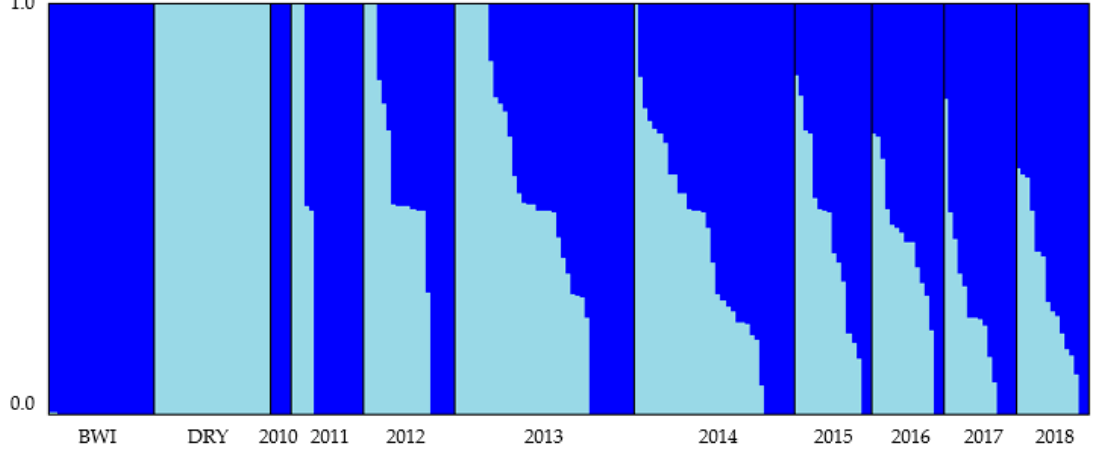
Figure 3. Summary of the clustering results from fastSTRUCTURE for the Matuwa translocated population of Bettongia lesueur assuming two admixed populations ( K = 2). Each individual is represented by a bar showing the individual’s estimated membership to a particular cluster (represented by different colors). Black lines separate samples from each of the founder populations (Barrow Island and Dryandra) and between years.